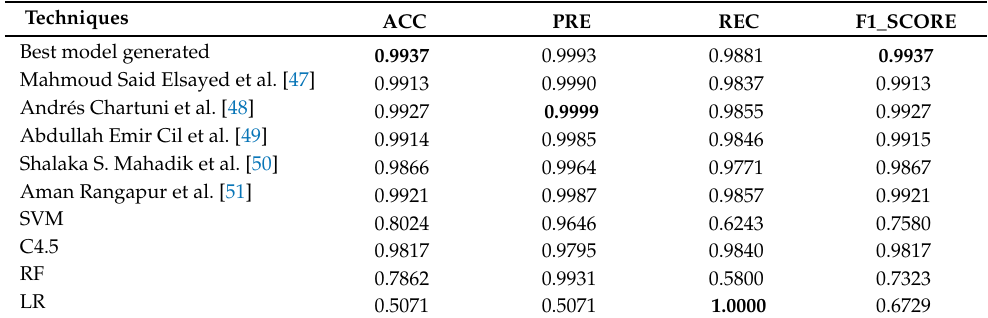
Table 10. The comparative Results with related works.